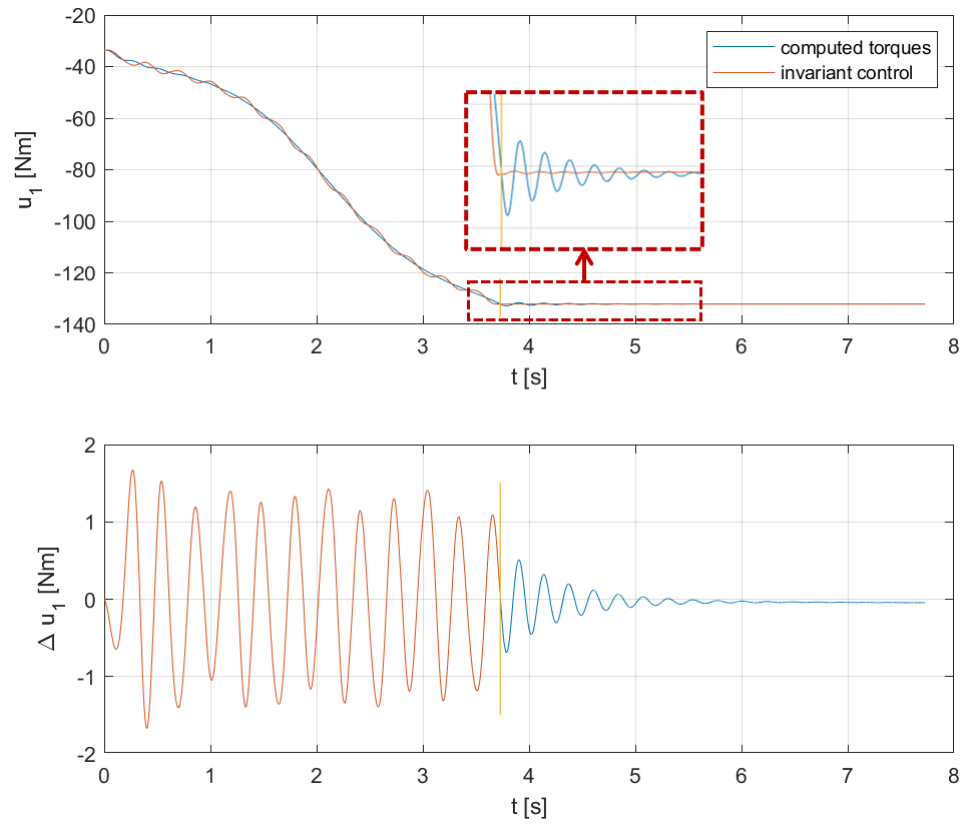
Figure 6. System input torque u 1 behaviour for two types of control—computed torques and invariant control and their